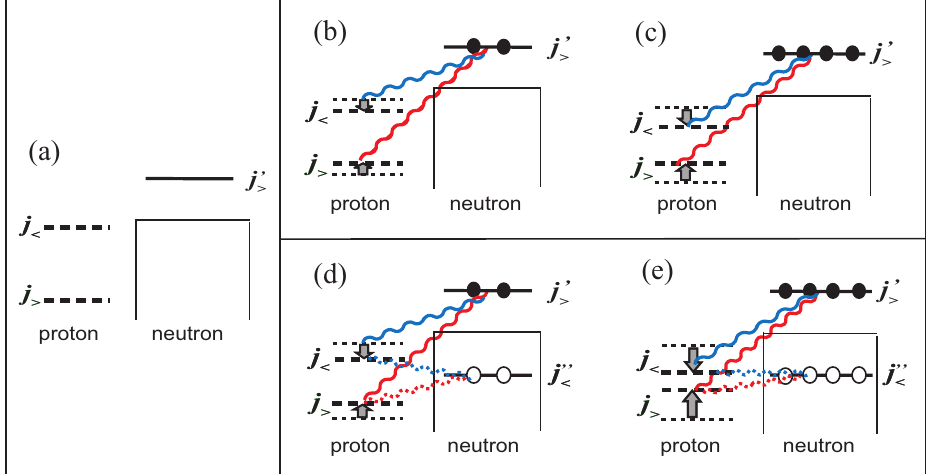
Figure 5. Schematic picture of the effective single-paticle energy (ESPE) change (i.e., shell evolution) due to the monopole interaction of the tensor force. ( a ) Single-particle energies (SPE) with no neutrons in the orbit j (cid:48) > . ( b ) The shifts in the proton ESPEs due to two (valence) neutrons in the orbit j (cid:48) > . ( c ) Same as ( b ) except for four neutrons. ( d , e ) Type-II shell evolution due to neutron particle–hole excitations. See text for more details. Taken from